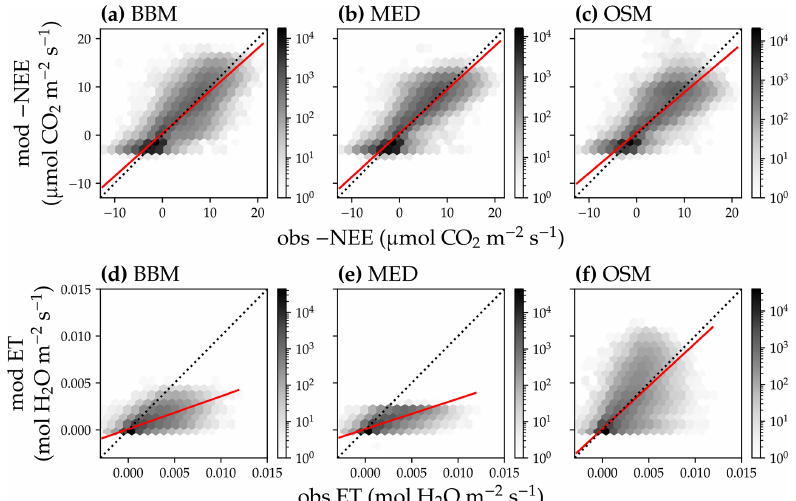
Figure 12. Comparison of half-hourly modeled and observed carbon and water fluxes for the three stomatal models for the US-NR1 (Niwot Ridge, evergreen gymnosperm forest) flux tower. (a) Comparison of modeled ( y axis) and observed ( x axis) net ecosystem carbon flux (NEE) for the Ball et al. (1987) stomatal model (BBM). Shading represents density: the darker the hexagon, the more data that fell within the hexagon. The red solid line plots the linear regression of the data, and the black dotted line plots the 1 : 1 line. (b) Comparison of NEE for the Medlyn et al. (2011) model (MED). (c) Comparison of NEE for the Wang et al. (2020) model (OSM). (d) Comparison of ecosystem water flux (ET) for the BBM. (e) Comparison of ET for the MED. (f) Comparison of ET for the OSM.